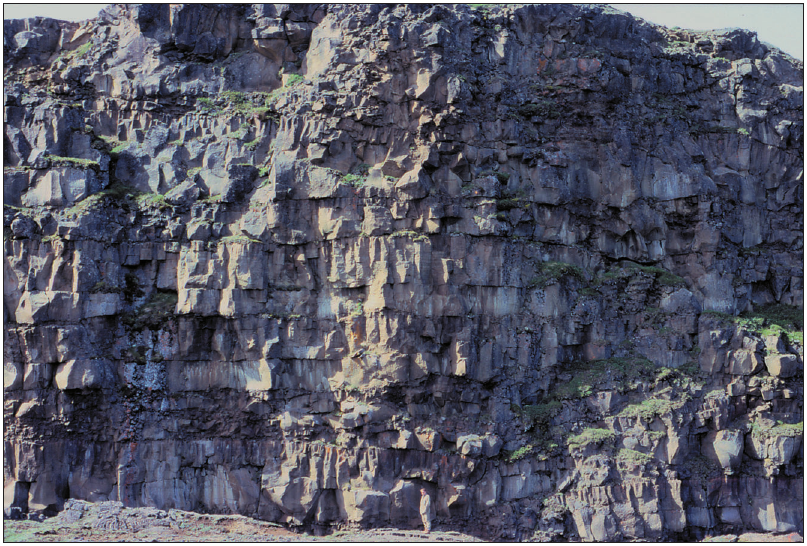
Fig. 2. Horizontal contacts between flow units and vertical columnar joints in a thick pahoehoe flow. Dykes that meet with such contacts commonly become offset or arrested. This 20-m-tall wall (see the person for scale) belongs to a normal fault that dissects the Krafla Volcanic System of the Holocene rift zone in North Iceland ( cf. fig.